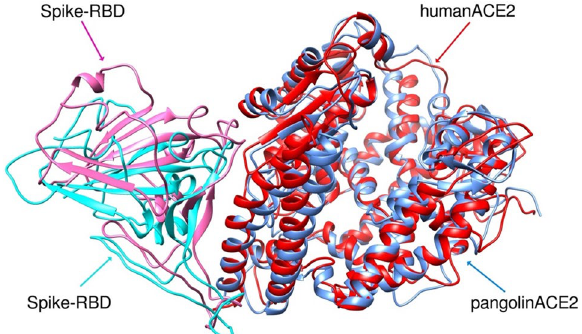
Figure 2. RMSD of overlay of S protein RBD (pink = with pangolin and turquoise = with human) complex with human ACE2 (red) or pangolin ACE2 (blue) after MD simulation showing different geometry of the two